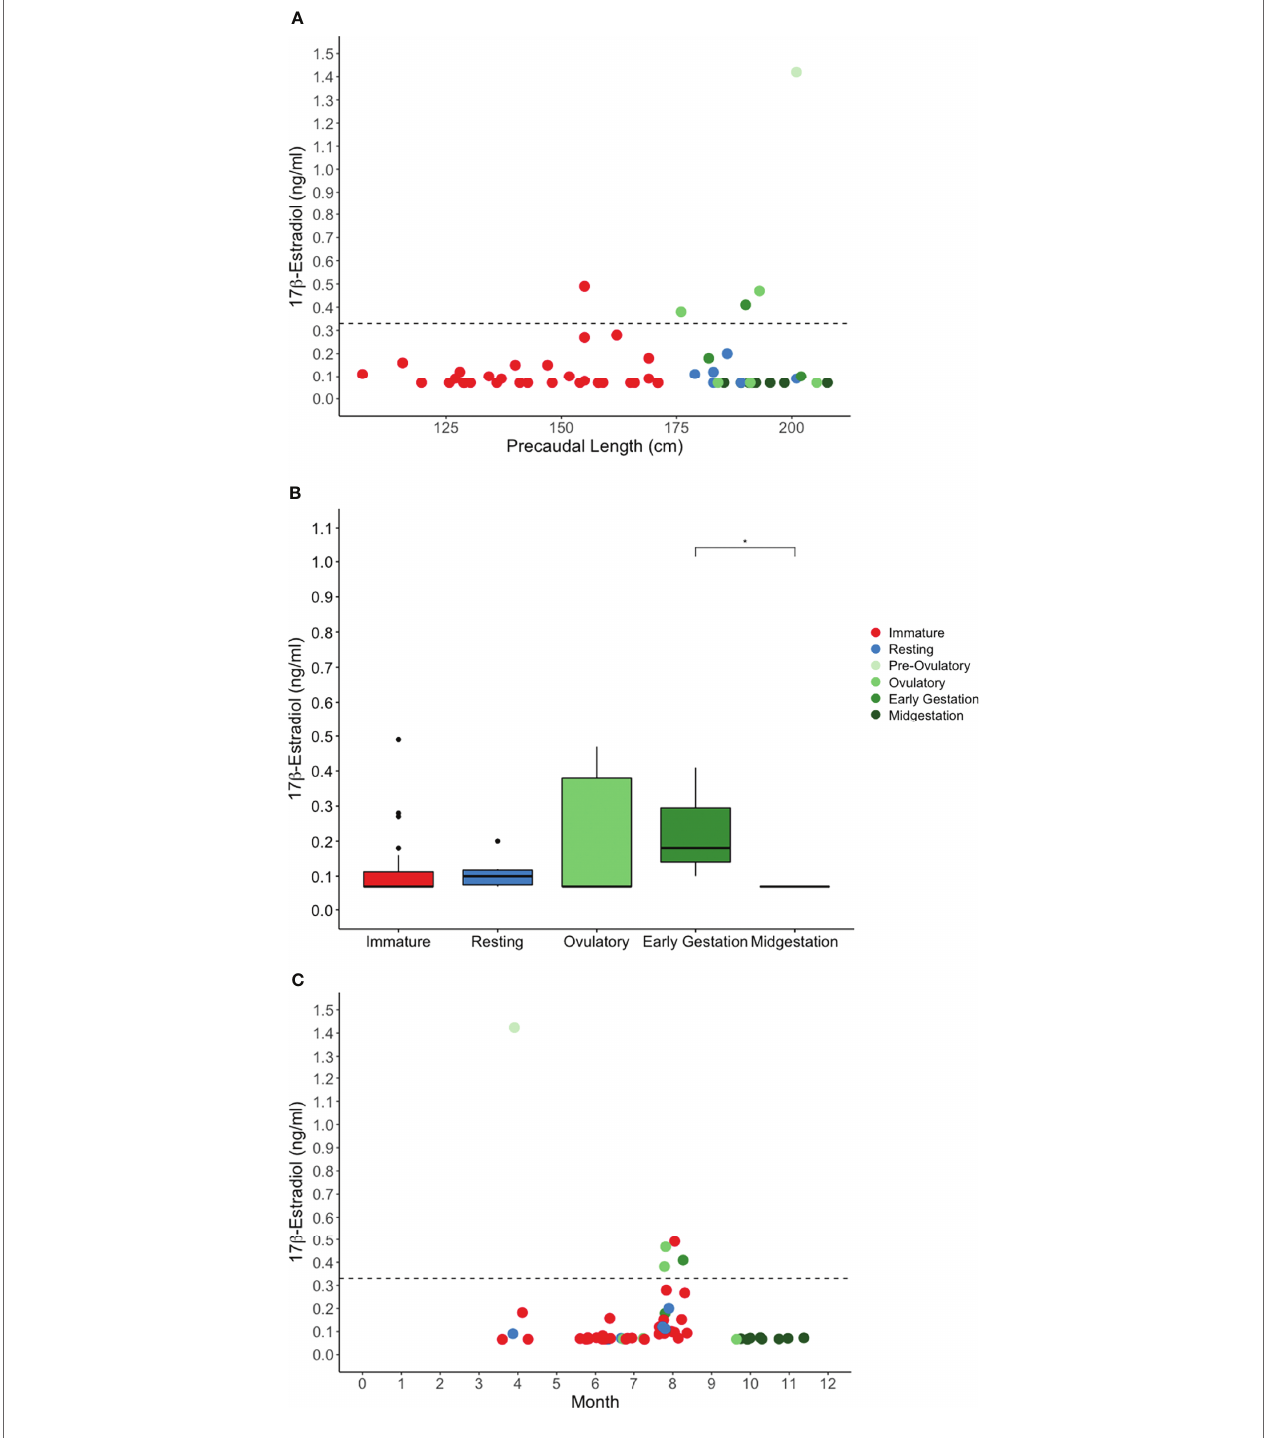
FIGURE 3 | Plasma 17 β -estradiol concentration by (A) shark length, (B) reproductive stage, and (C) month for in situ sand tiger sharks. Color indicates reproductive stage and the dotted line represents the threshold for elevated hormone concentration. Early gestation and midgestation 17 β -estradiol were significantly different (* P =